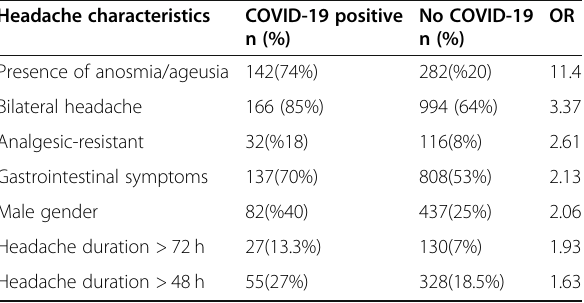
Table 2 Odds ratios of differentiating variables of the headache in patients with COVID-19 diagnosis Headache